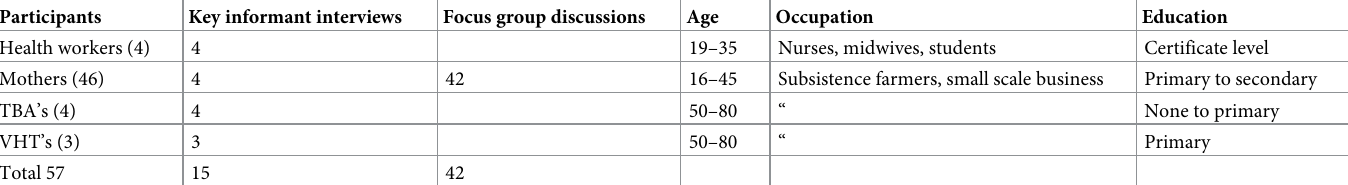
Table 1. Characteristics of